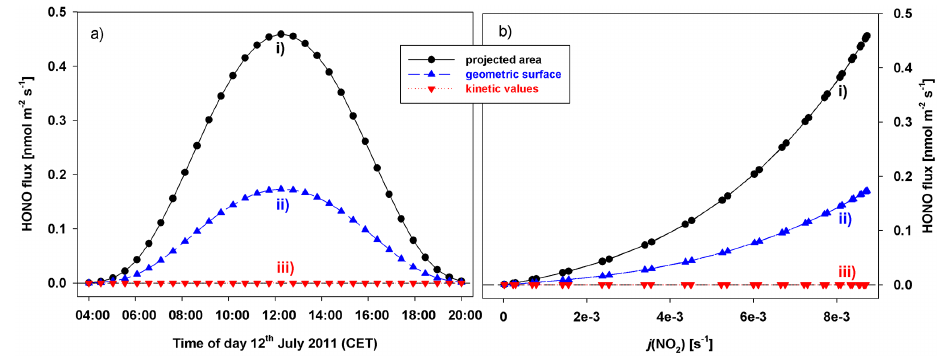
Figure 5. HONO fluxes from photolysis of adsorbed HNO 3 calculated by three different approaches (for details see text). Diurnal cycles of the HONO fluxes are shown in panel (a) , whereas panel (b) shows the relationship between HONO fluxes and j (NO 2